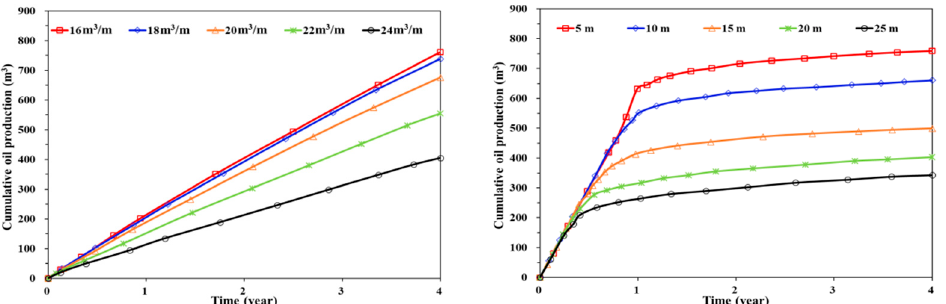
Figure 24. Sand volume intensity and fracturing spacing sensitivity.